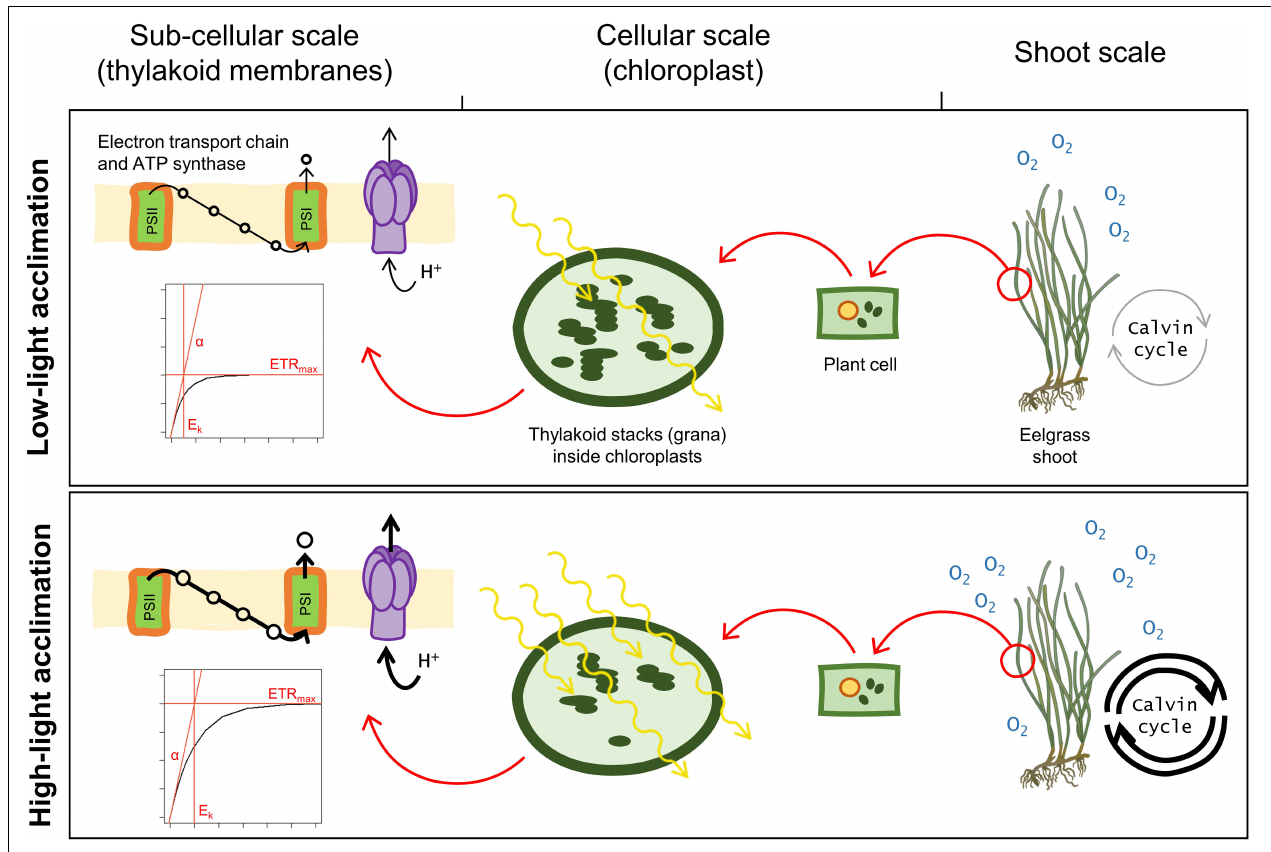
FIGURE 6 | Photoacclimation responses of eelgrass shoots to low and high light, observed after 25 days of light exposure. The limit between low and high light was drawn at 200 µ mol photons m − 2 s − 1 , based on E k measurements. The low-light acclimation response illustrated here only sums up the observations made for the 74 and the 133 µ mol photons m − 2 s − 1 treatments, which are irradiances for which photoacclimation was sufficient to prevent any shoot decay. The figure shows the highest photosynthetic capacity (ETR max ) and the onset of light saturation (E k ) of the high-light acclimated shoots compared to the low-light acclimated ones, suggesting a more efficient electron transport chain. Photosynthetic efficiency (alpha) was similar in both light conditions. Higher pigment contents in low-light acclimated shoots are illustrated by an increased number of thylakoids inside the chloroplasts. Light absorption, represented by the wavy yellow arrows, was constant amongst light conditions. Low-light acclimated shoots had lower primary production (GPP), and presumably a lower Calvin cycle activity than high-light acclimated ones.